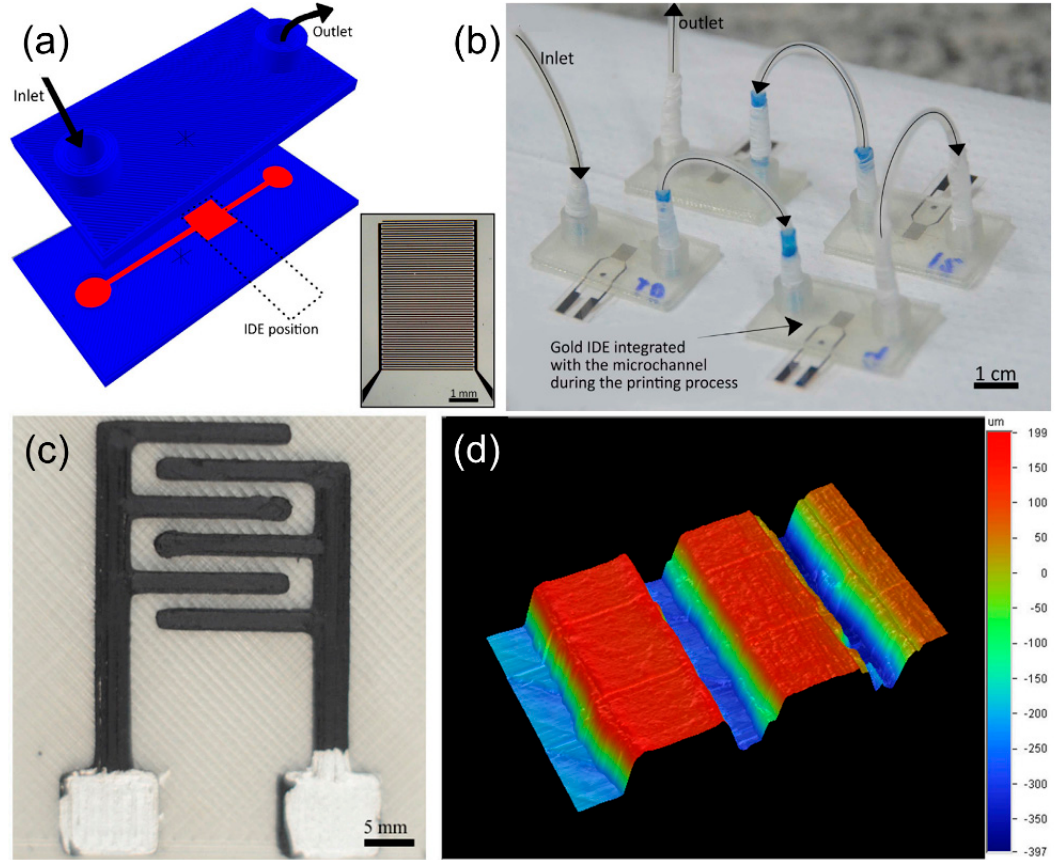
Figure 5. ( a ) Three-dimensional (3D) model of the electronic tongue sensor (the microchannel is in red). The interdigitated electrodes (IDEs) were manually inserted during the printing process; ( b ) photo of the microfluidic electronic tongue system ((a) and (b) reprinted from [37] with permission from Elsevier (license 4684171493577)); ( c ) 3D printed IDEs with three pairs of fingers 9 mm long, 1 mm wide, and intervals with 0.4 mm thickness; ( d ) 3D profilometry mapping of the printed IDE to estimate the root mean square (RMSS) surface roughness [38]. © 2018 Gaál, da Silva, Gaál, Hensel, Amaral, Rodrigues, and Riul.